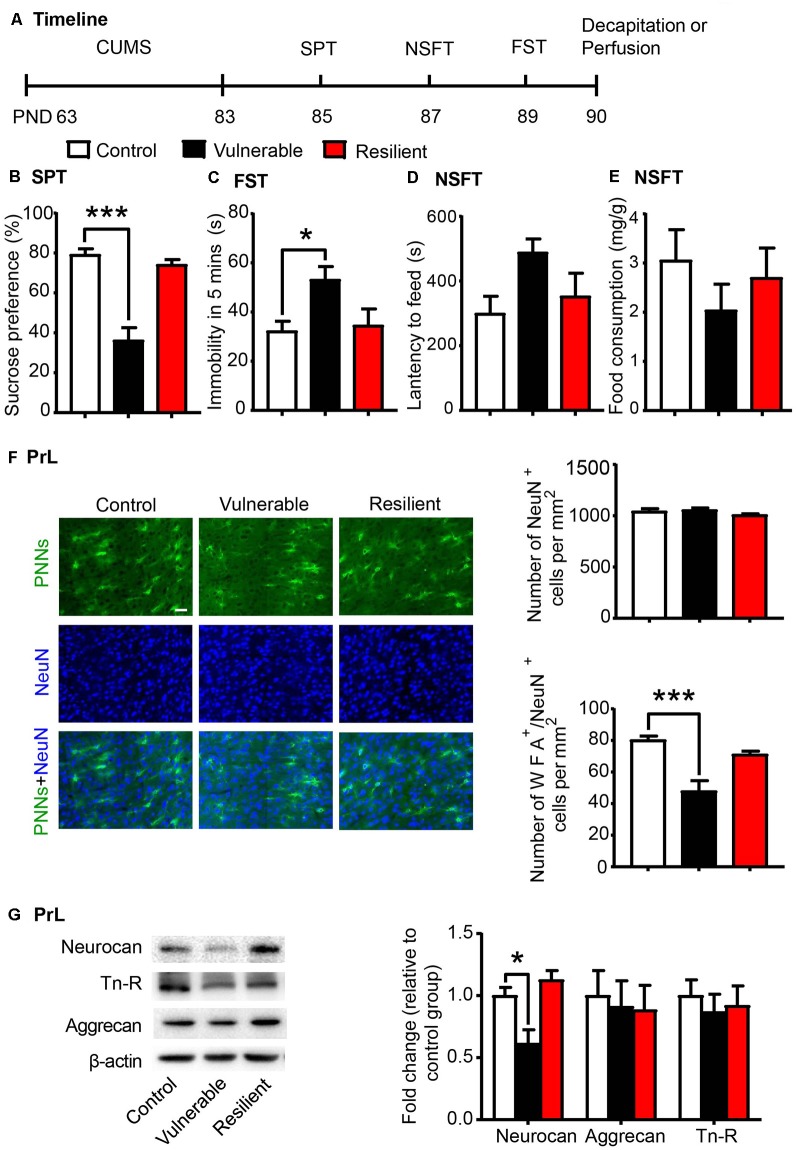
CUMS-vulnerable rats exhibited a lower density of Perineuronal nets (PNNs) in the PrL compared to control and resilient rats. (A) Timeline of the experimental procedure (n = 8 per group). (B) Sucrose preference in the SPT. (C) Immobility time in the FST. (D) Latency to feed and (E) food intake in home cage in the NSFT after 20 days of chronic unpredictable mile stress (CUMS). The vulnerable rats displayed anhedonia and helpless behavior, while resilient rats did not. (F) Representative images of immunofluorescence staining of PNNs and quantification of NeuN+ and WFA+/NeuN+ cells in the PrL (n = 6 per group). Scale bar = 50 μm. (G) Representative western blots and quantification of fold changes in protein levels of PNNs components including neurocan, aggrecan and tenascin-R (Tn-R) in the PrL (n = 8 per group). The data are expressed as mean ± SEM. *p < 0.05, ***p < 0.001. PND, postnatal day.